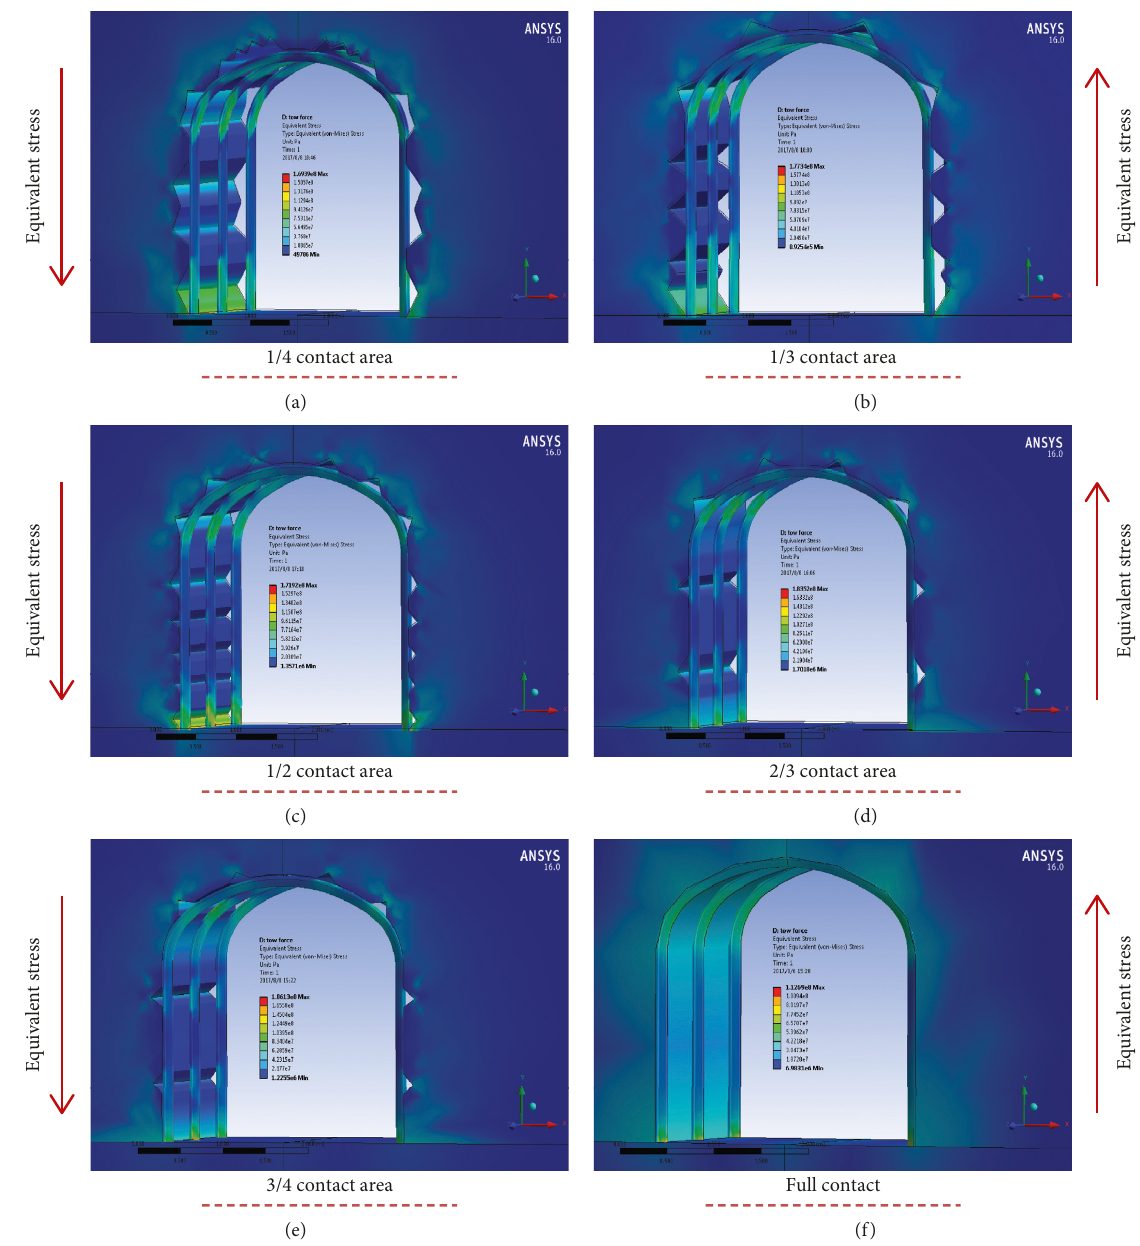
Figure 8: The overall equivalent stress. The equivalent stress is based on the stress contour line to express the stress distribution in the model. It can clearly describe the variation in a result in the whole model so that it can quickly determine the most dangerous region in the model. The equivalent stress maps with contact area ratios of (a) 1/4, (b) 1/3, (c) 1/2, (d) 2/3, (e) 3/4, and (f) 1 are shown. The maximum values